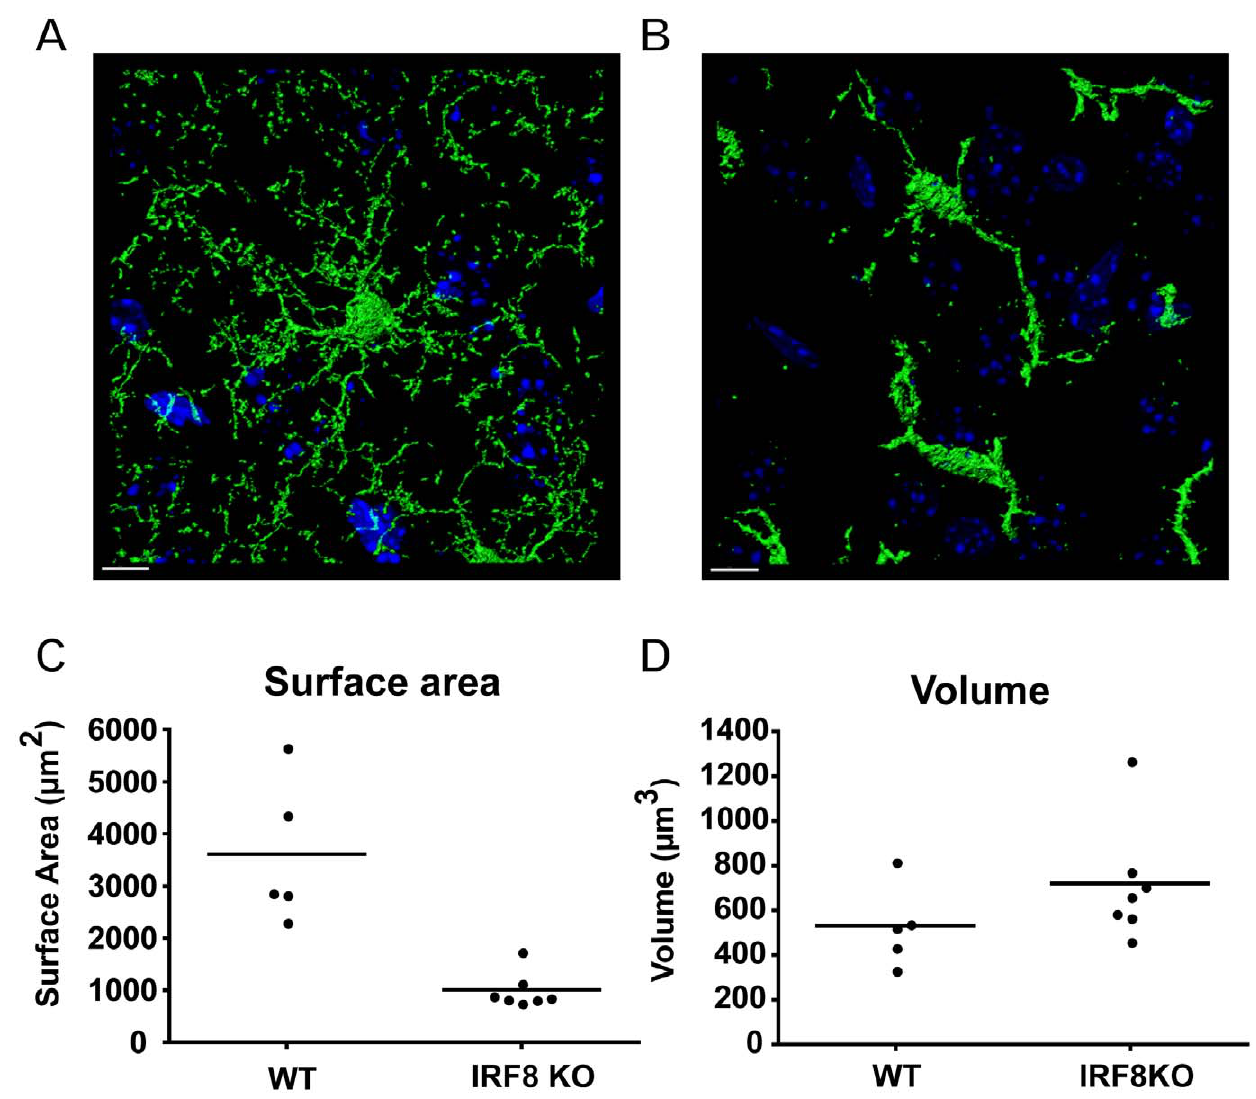
Figure 2. IRF8-deficient microglia have a marked reduction in ramification and surface area. Representative confocal images of eGFP positive WT (A) and IRF8-deficient (B) microglia in the cortex, counterstained with DAPI (blue) were obtained from 100 m m vibratome sections on a Zeiss LSM 510 Meta confocal microscope. The 3D analysis (surface rendering) was performed using Bitplane Imaris software. Size bar=10 m m. Quantification of single-cell surface area (C) and volume (D) for microglia in the cortex of WT (n=5) or IRF8-deficient (n=7) mice. Values are shown with the bar representing the mean. IRF8-deficient microglia showed a significant (p , 0.0025; Mann-Whitney U test) reduction in cell surface area and although cellular volume of these cells was increased slightly this was not